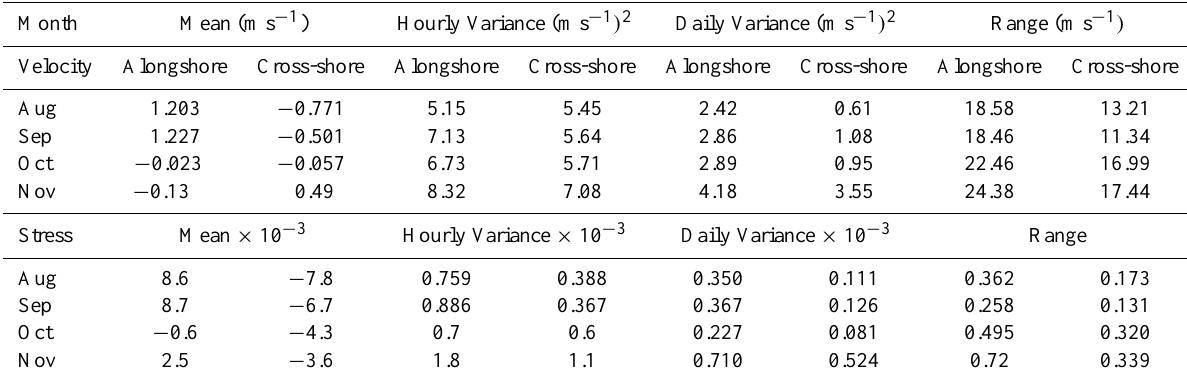
Table 1. Mean variance and range of wind velocity and wind